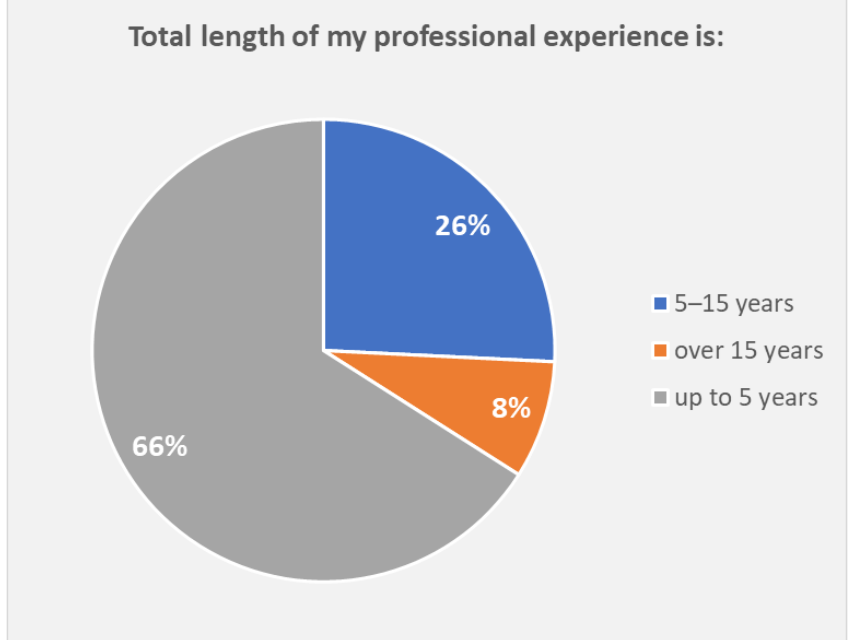
Figure 4. Structure of the professional experience among respondents.